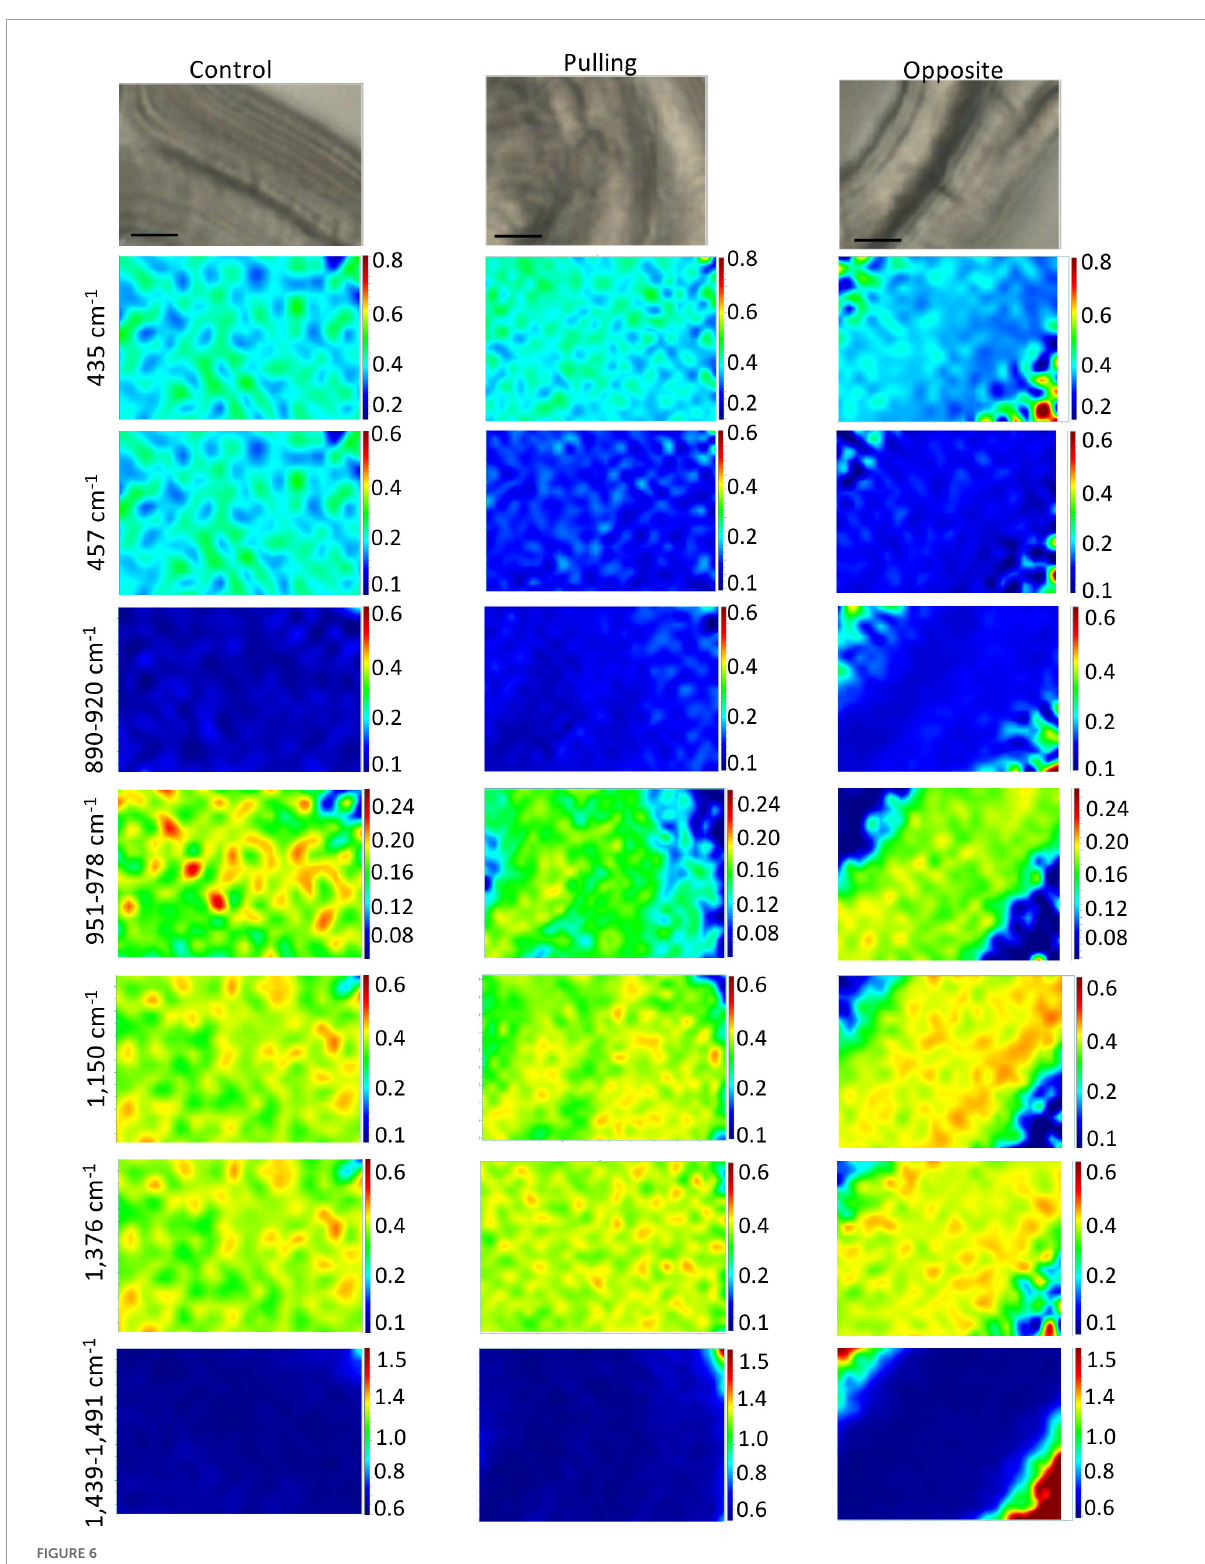
FIGURE6 Raman chemical cartography of ratio (cellulose band/reference band 379 cm − 1 ): major contributions of cellulose (435; 457; 890–920; 1,150; 1,376 cm − 1 ) and cellulose/xyloglucan (1,439–1,491 cm − 1 ). Color scale bar indicates pixel intensity for the imaged peak (red = high, blue = low). Within one peak, the color scale intensities were the same for each